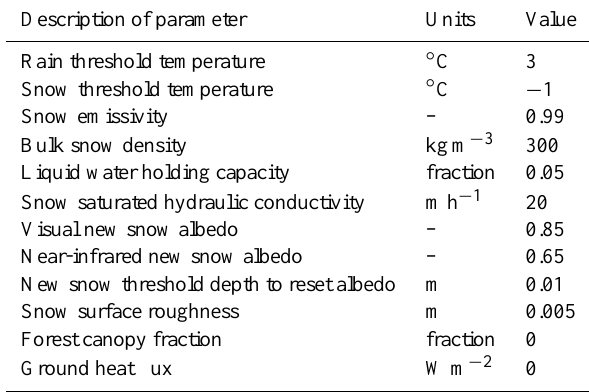
Table 2. UEB model parameters used in all simulations and